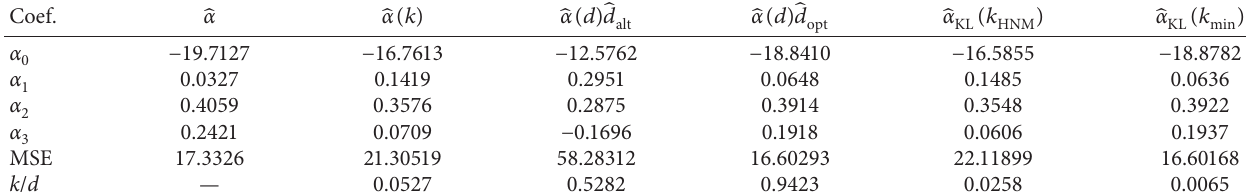
Table 11: The results of regression coefficients and the corresponding MSE values. Coef.